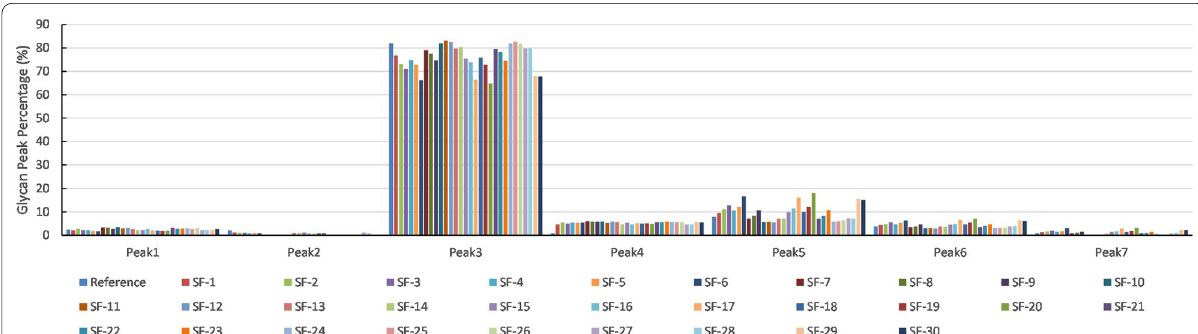
Fig. 1 Glycan peak distribution of 30 samples from the shaker flask culture experiment. Each peak percentage denotes one glycoform from the antibody. Peak 3 is the most abundance glycan an peak 5 is the second portion. The reference glycan distribution is the first column in each peak